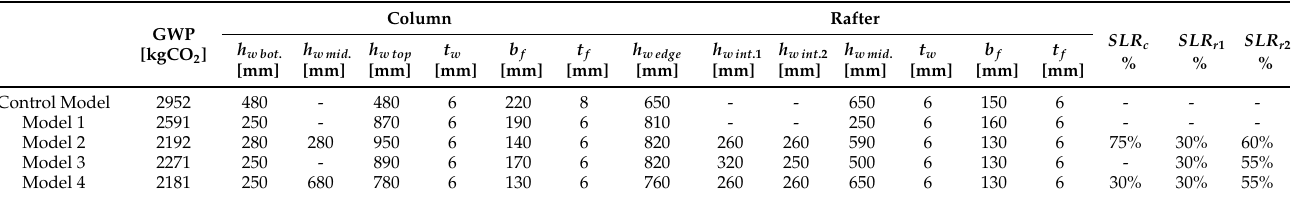
Table 8. A sample of the optimal designs of different models.